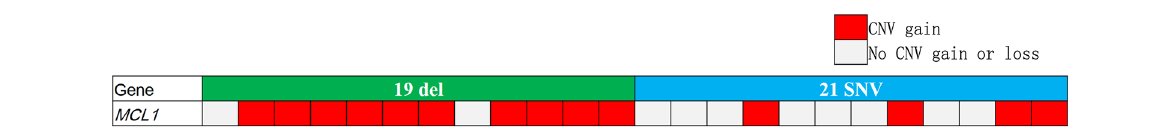
Fig. 4 Copy number variation (CNV) of myeloid cell leukemia sequence 1 ( MCL1 ) in 12 pairs of patients with the EGFR 19 del or L858R mutation. The red squares represent the gain of MCL1 CNV. The blank squares represent no gain or loss of MCL1